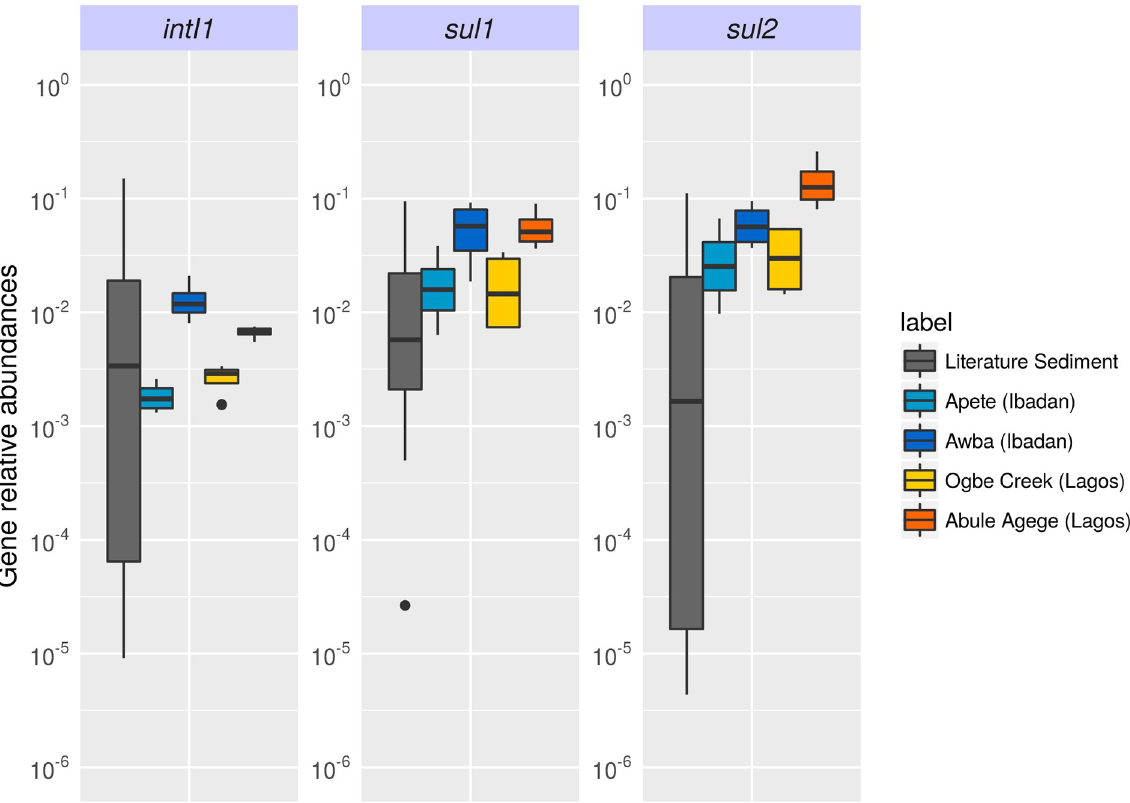
Fig 3. Relative abundance of indicator ARGs from our study sites (coloured bars) compared to similar sites in China [43,46,47,49–51], Pakistan [52], Poland [48], Sweden [45], Switzerland [44] and USA [42] (grey bars).